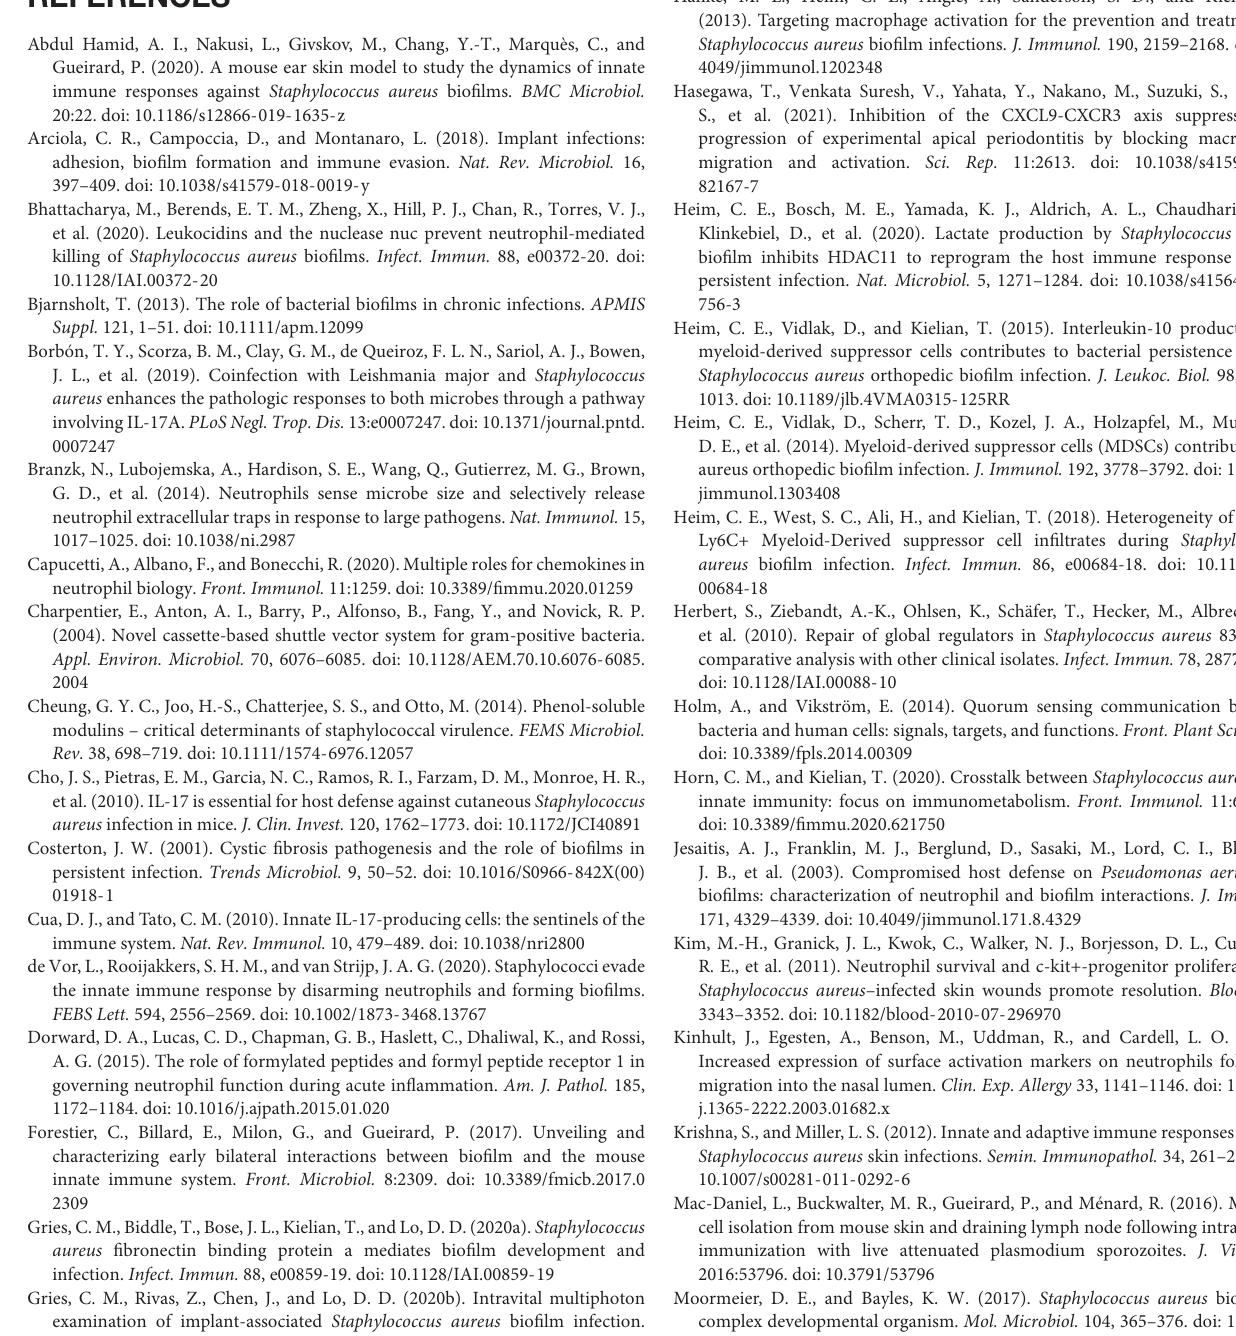
(E) Quantification of intracellular bacteria, expressed in CFUs/10 6 cells, in CD11b + cells isolated from ear pinna tissue of planktonic or biofilm infected mice, at 24 and 48 h pi (median ± IQR, number of mice: N P = 5, N BF = 3–4, from at least 3 different experiments, Mann-Whitney one-tailed test, ∗ p < 0.05). Supplementary Movie 1 | EGFP + innate immune cells are recruited toward a planktonic injection site. In vivo confocal time-lapse imaging of immune cell migration in LysM-EGFP transgenic mice ear tissue injected with planktonic